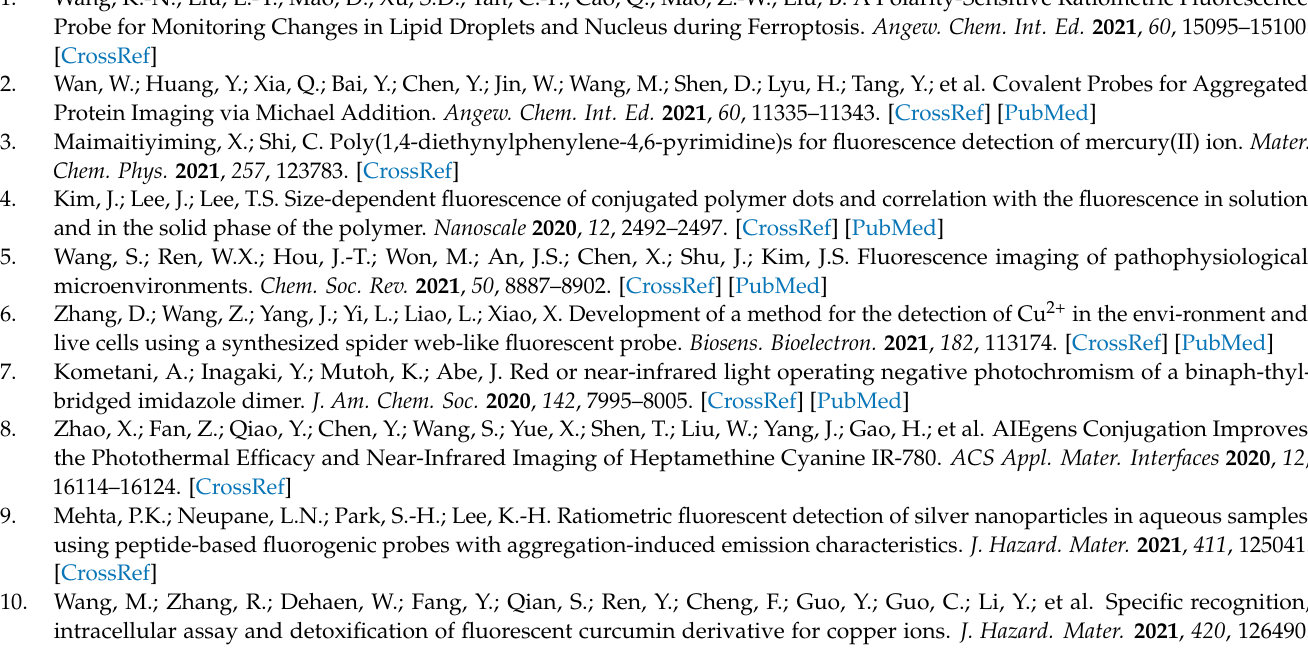
of Zn 2+ and the linear relationship between CPBI 4 and low concentrations of Zn 2+ , λ ex = 375 nm; Figure S28. Stern-Volmer diagram of the interaction of sensors CPBI4 with Cu 2+ (a) and Zn 2+ (b) (the illustration shows the Stern-Volmer linear diagram at low concentrations); Figure S29. FT-IR spectra (a), SEM images of CPBI 1 before and after the addition of Cu 2+ or Zn 2+ (b: CPBI 1 + Zn 2+ ; c: CPBI 1 + Cu 2+ ; d: CPBI 1 ); Figure S30. FT-IR spectra (a), SEM images of CPBI 3 before and after the addition of Cu2+ or Zn 2+ (b: CPBI 3 + Zn 2+ ; c: CPBI 3 + Cu 2+ ; d: CPBI 3 ); Figure S31. FT-IR spectra (a), SEM images of CPBI 4 before and after the addition of Cu 2+ or Zn 2+ (b: CPBI 4 + Zn 2+ ; c: CPBI 4 + Cu 2+ ; d: CPBI 4 ); +; Figure S32. Time-correlated single photon counting (TCSPC) plot for CPBI 2 (left) and CPBI 4 (right) interacted with Cu 2+ and Zn 2+ ( λ ex = 375 nm, λ em = 504 nm for CPBI 2 and λ em = 510 nm for CPBI 4 , respectively). Table S1. The effects of different feed ratios on yield, color and actual alkylation rate of CPBIn; Table S2. The thermal decomposition temperatures of CPBIs with different feed ratios; Table S3. Photophysical properties of CPBIn with different feed ratios. Table S4. Comparison of LOD when the sensor CPBI n detects Cu 2+ and Zn 2+ ; Table S5. The comparison of probe CPBIn with the reported Cu 2+ probes in solution; Table S6. The comparison of probe CPBI n with the reported Zn 2+ probes in